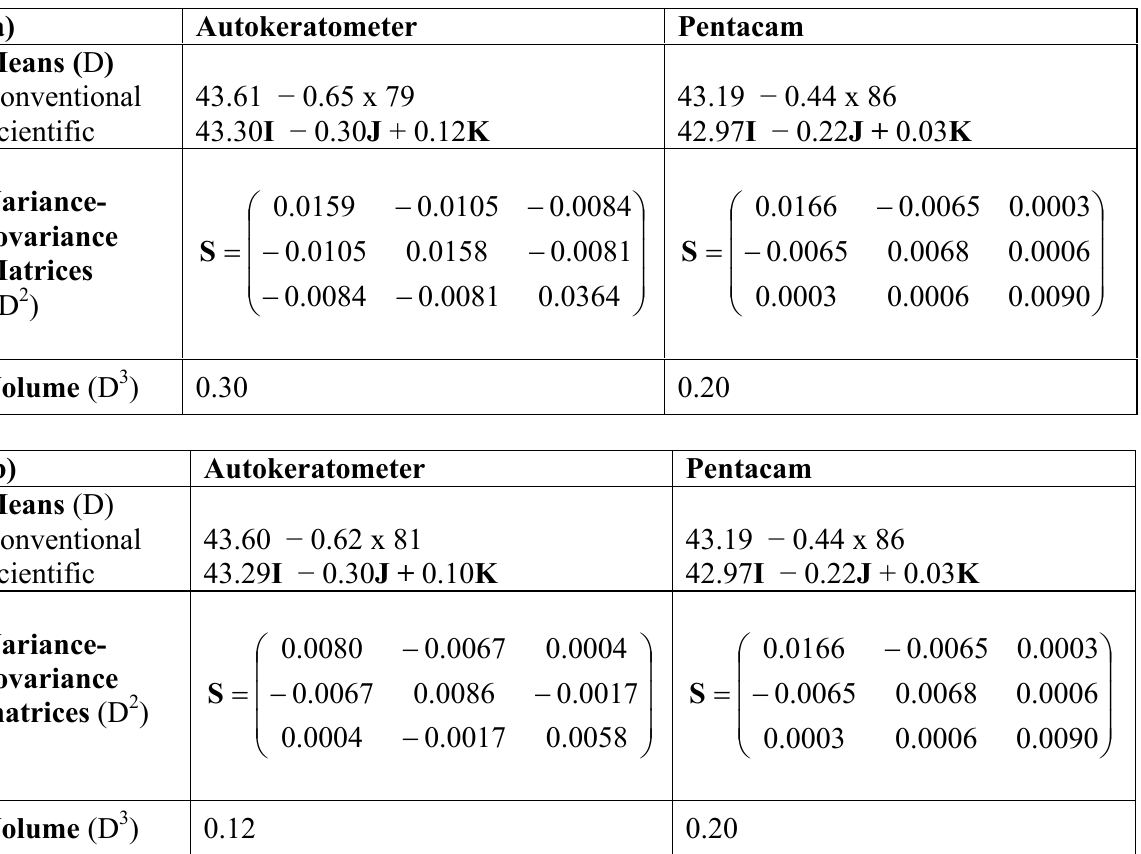
Table 1 . Statistics for the right eye of a single subject (Subject 1) for the samples of autokeratometry and Pentacam measurements are given. The mean powers, variance-covariance matrices and the volumes of the ellipsoids of constant probability density containing an estimated 95% of the population of measurements with (a) and without (b) outliers are